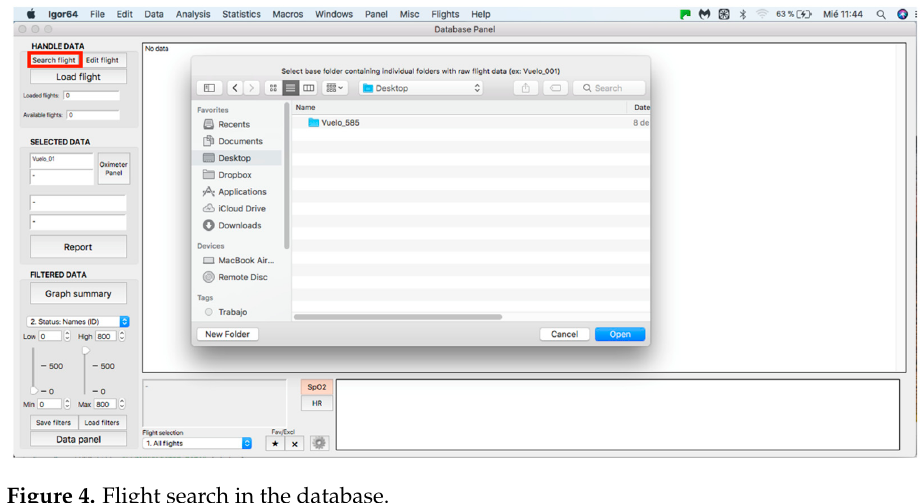
Figure 4. Flight search in the database.